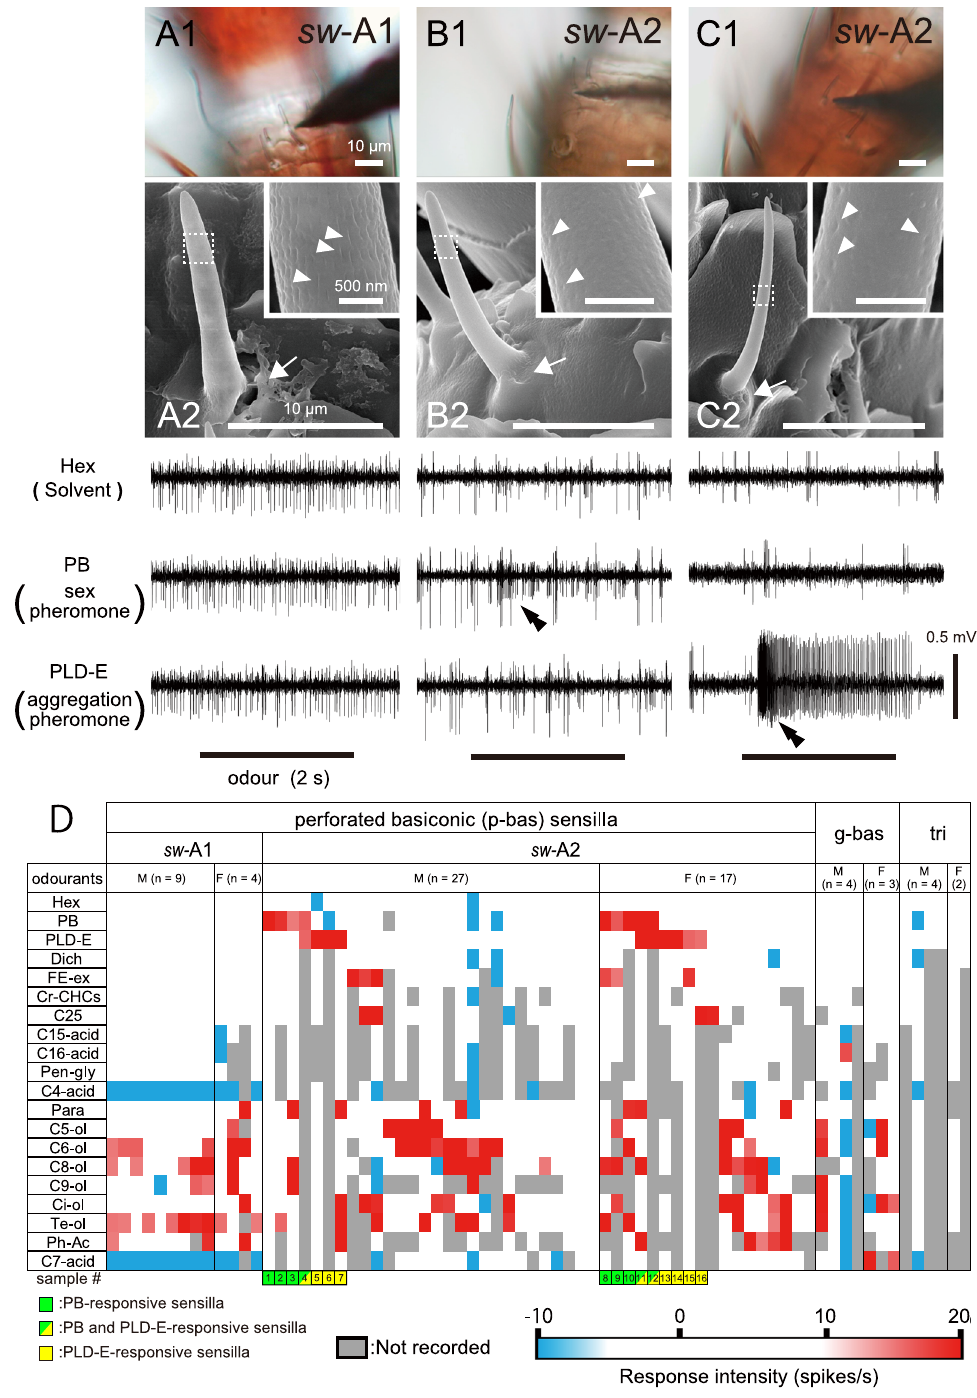
Figure 2. Olfactory responses of single sensilla on the nymphal antennae. ( A – C ) Typical responses and morphological features of sw- A1 ( A ), PB-responsive sw- A2 ( B ), and PLD-E-responsive sw- A2 sensilla ( C ). Because we could not identify sensillar types of sw -A sensilla under the light microscope (A1–C1), recorded sensilla were observed using SEM in detail (A2–C2). SEM observation reveals olfactory pores of recorded sensilla (arrowheads in insets of A2–C2). Arrows in A2–C2 indicate the insertion sites of electrodes. Sex and aggregation pheromones elicited small-amplitude and large-amplitude spikes in single sw- A2 sensilla, respectively (double arrowheads in B,C). ( D ) Response intensities of single sensilla to tested odourants. Response intensity to a given odourant is colour-coded according to the “R − R0” value (see Material and Methods). Excitatory and inhibitory responses are shown as warm and cold colours, respectively. 16 sw- A2 sensilla which exhibited excitatory responses to PB and/or PLD-E are numbered (sample numbers below the heatmap). M: male, F: female. g-bas: grooved basiconic sensilla. tri: trichoid